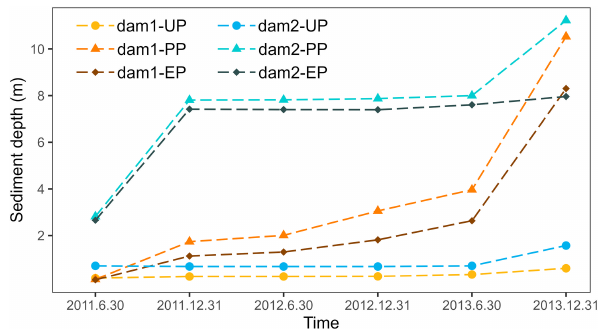
Figure 8. The depth of deposited sediment in the dams’ placements.